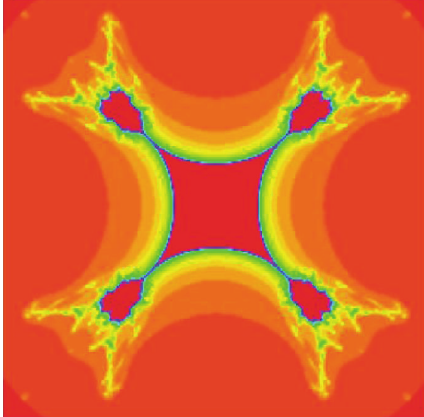
Figure 14: Relative superior multicorn for 𝑠 = 0.5 and 𝑠 󸀠 = 0.6 .